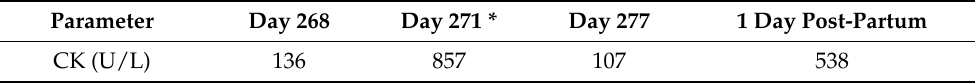
Table 1. Trend of serum creatine kinase (CK) concentration during the hospitalization period. Parameter Day 268 Day 271 * Day